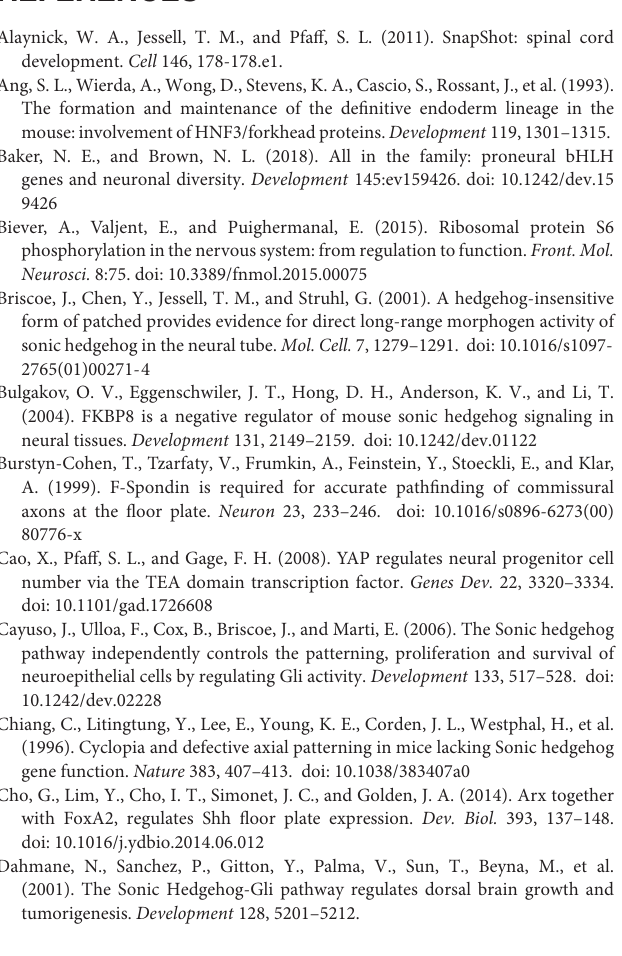
FIGURE S4 | Blocking RNF152 expression or activation of mTOR signal leads to aberrant pS6 upregulation without affecting the FoxA2 expression in the floor